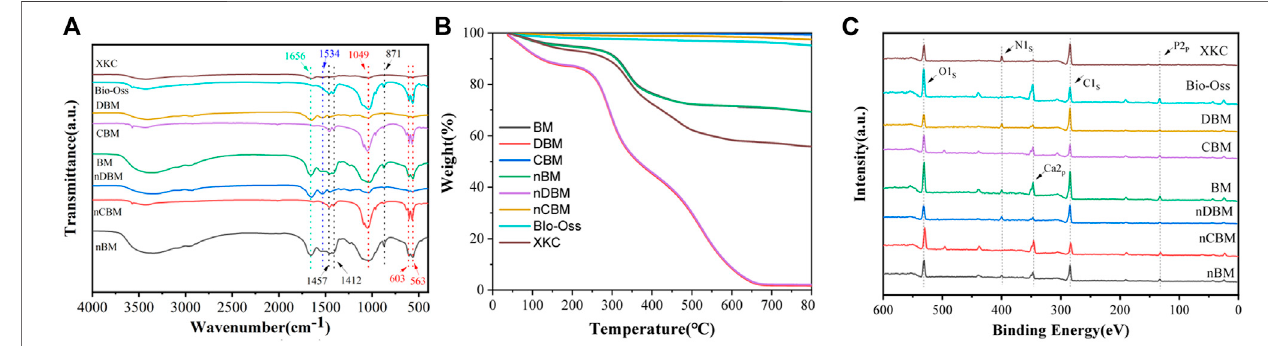
FIGURE 4 | Fourier transform infrared spectroscopy spectra (A) , TGA (B) , and XPS spectrum (C) of different bone powders. Red dotted line: absorption peaks of PO 43 − ; black dotted line: absorption peaks of CO 32 − ; blue dotted line: absorption peaks of amide II; green dotted line: absorption peaks of amide I.